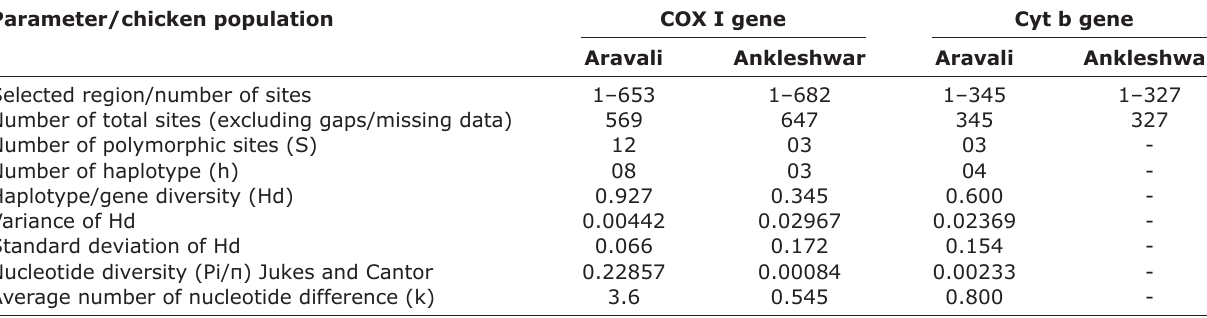
Figure-1: Agarose gel electrophoresis (2%) of COX I (746 bp, a) and Cyt b (415 bp, b) amplicons of representative samples of Aravali (lanes: 1-5, in a and b) and Ankleshwar (lanes: 7-11, in a and b) populations. Size standard: 100 bp ladder (lane 6 in a and Table-1: Comparative haplotype analysis of COX I and Cyt b genes between Aravali and Ankleshwar chicken populations. Parameter/chicken population